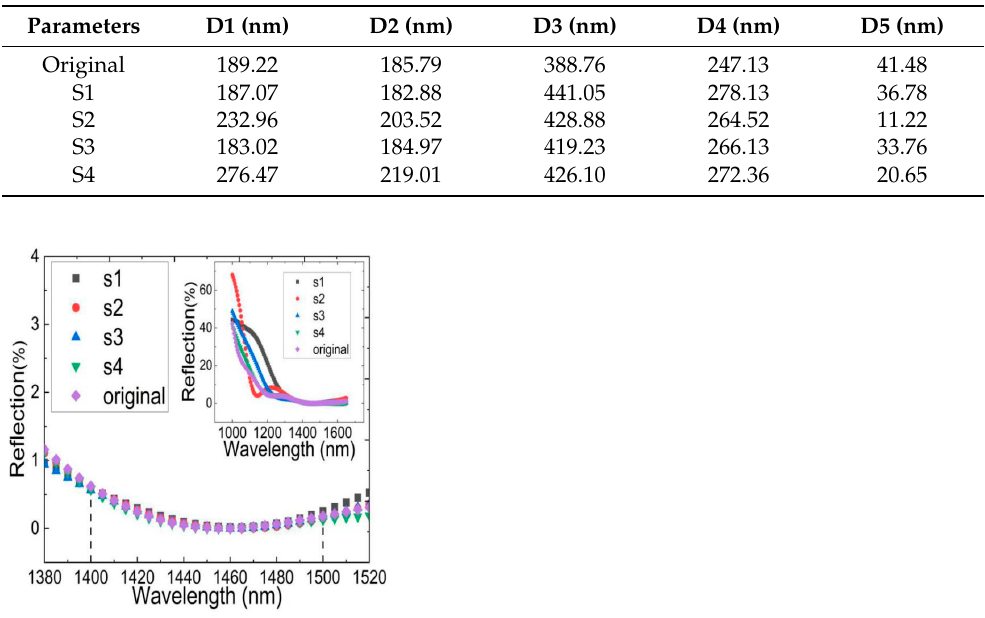
Figure 5. The reflection spectra for various structures inversely designed by NN-PSO for the same 1400~1500 nm wavelength range. 1400~1500 nm wavelength